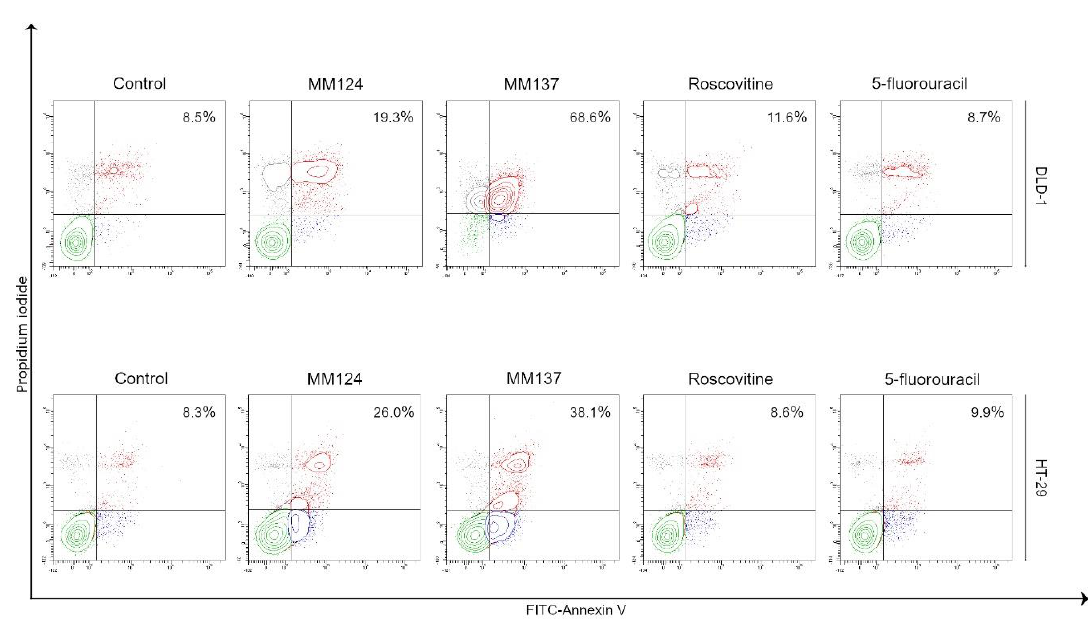
Figure 3. Induction of apoptosis in human HT-29 and DLD-1 cells incubated for 24 h with novel 7-methyl-5-phenyl-pyrazolo[4,3- e ]tetrazolo[4,5- b ][1,2,4]triazine sulfonamide derivatives (MM124, MM137), 5-fluorouracil, and roscovitine at 0.5 µM. Concentration was evaluated by Annexin V binding assay. The number of early and late apoptotic cells is presented as mean percentage value from three independent experiments done in duplicate.